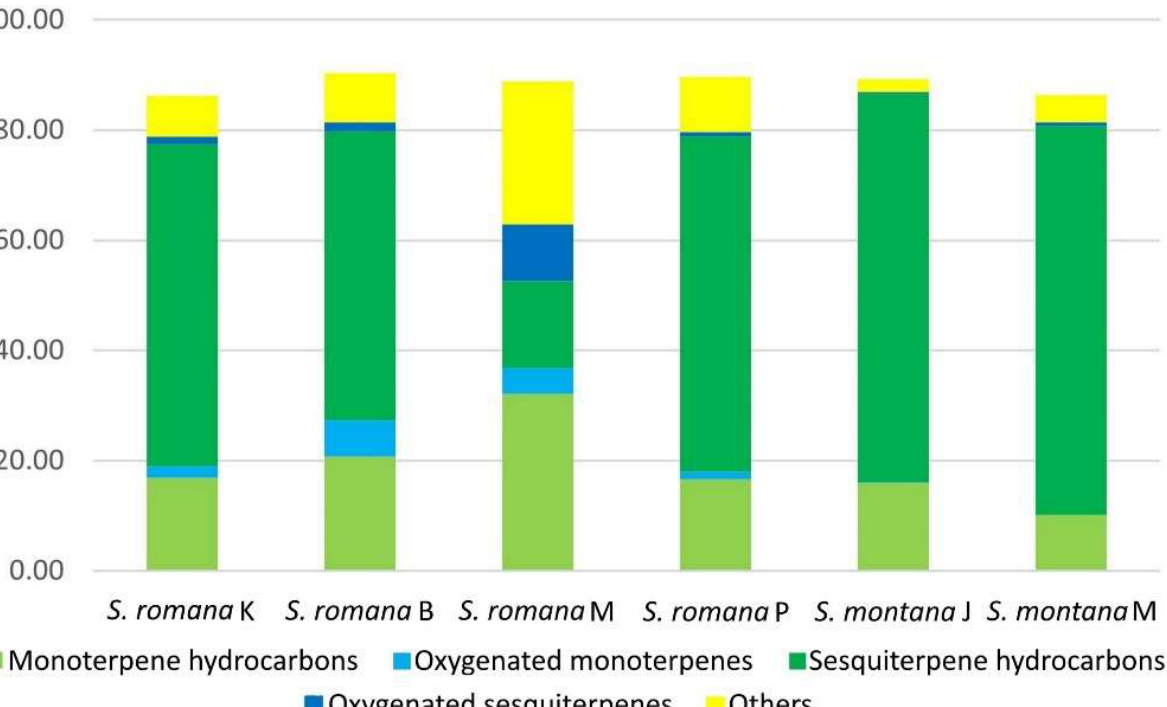
Figure 1. Average relative percentages of different classes of headspace volatile organic compounds obtained from various populations of S. romana and S. montana using DVB/CAR/PDMS fiber.